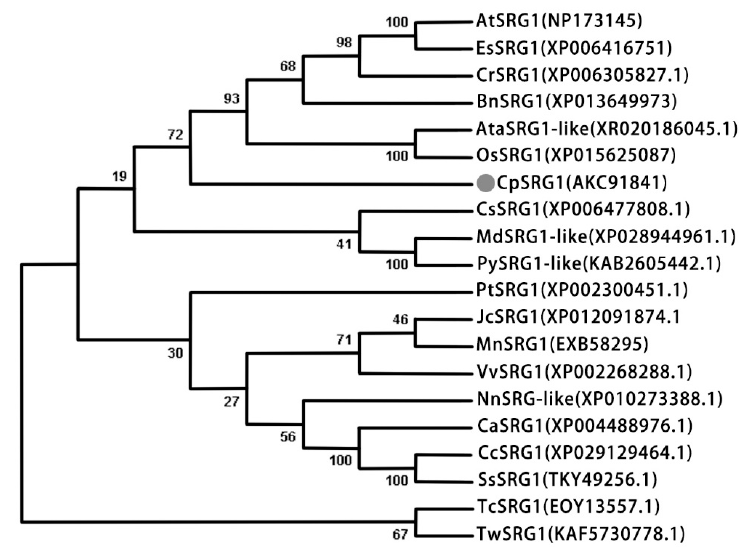
Figure 2. A phylogenetic tree of CpSRG1 and SRG1 proteins from other species. Phylogenetic analysis was performed by the neighbor-joining (NJ) method with 1000 bootstrap replicates using MEGA 7.0. At, Arabidopsis thaliana; Es, Eutrema salsugineum ; Cr, Capsella rubella ; Bn, Brassica napus ; Ata, Aegilops tauschii subsp. Tauschii ; Os, Oryza sativa; Cp, Chimonanthus praecox; Cs, Citrus sinensis ; Md, Malus domestica ; Py, Pyrus ussuriensis x Pyrus communis ; Pt, Populus trichocarpa ; Jc, Jatropha curcas ; Mn, Morus notabilis ; Vv, Vitis vinifera L.; Nn, Nelumbo nucifera ; Ca, Cicer arietinum ; Cc, Cajanus cajan ; Ss, Spatholobus suberectus ; Tc, Theobroma cacao ; Tw, Tripterygium wilfordii .